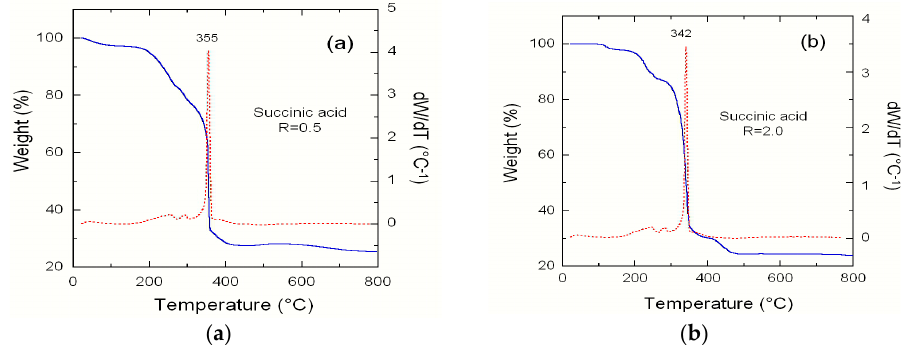
Table 4. Structural data of the LiNi 1/3 Mn 1/3 Co 1/3 O 2 samples synthesized at different values of R . a , c